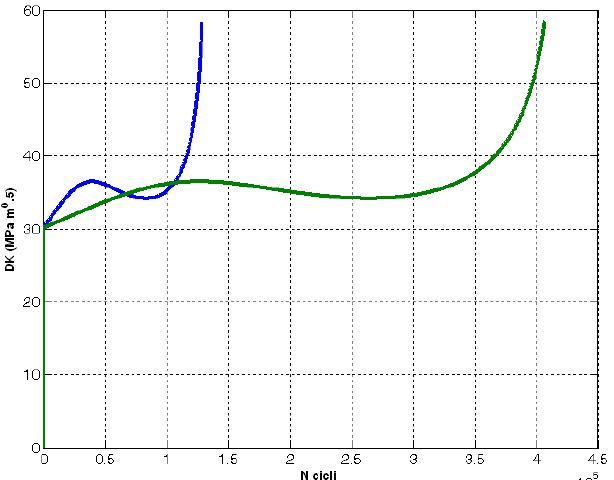
Figura 8: Parametro  K di sollecitazione della fessura; in blu ed in verde le curve relative alla (1) e alla (2) rispettivamente.